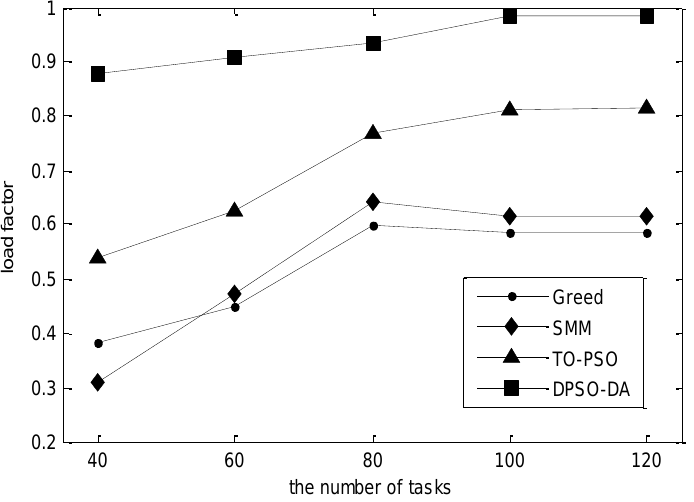
Figure 10. The network load for the dynamic tasks under different task allocation solutions.